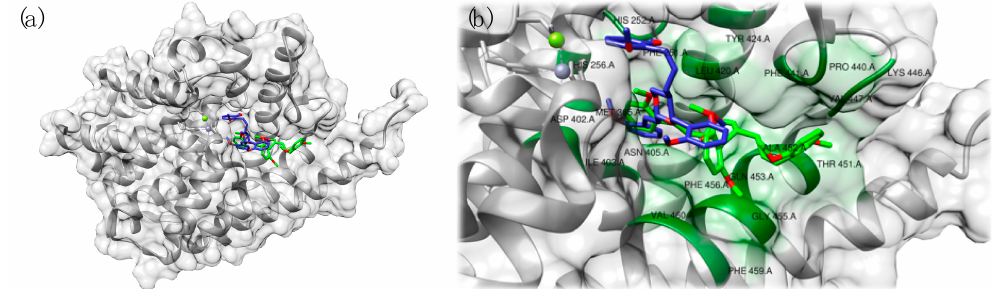
Figure 11. Results of the docking study based on the chemical structures of the natural PDE9 inhibitors ( ± )-torreyunlignans reported by Cheng et al. [58]. View of the full protein ( a ) and detailed view of the interaction pattern of 3a (green) and 3b (blue): the residues involved in the binding have been labeled and highlighted in green ( b ).